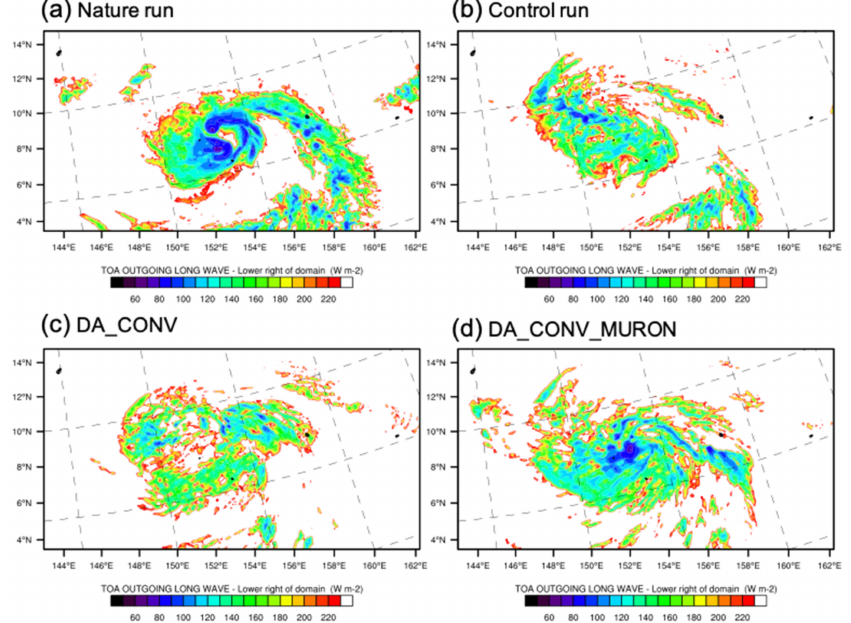
Figure 12. Outgoing Longwave Radiation (OLR) for ( a ) the nature run, ( b ) the control run, forecasts initialized by ( c ) the DA_CONV analysis, and ( d ) the DA_CONV_MURON analysis valid at 0000 UTC 4 November